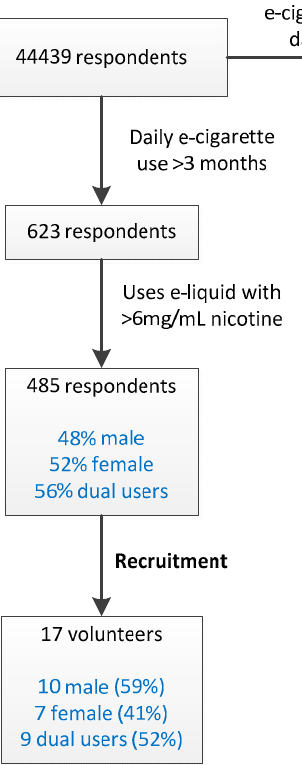
Figure 1. Screening and recruitment of volunteers.